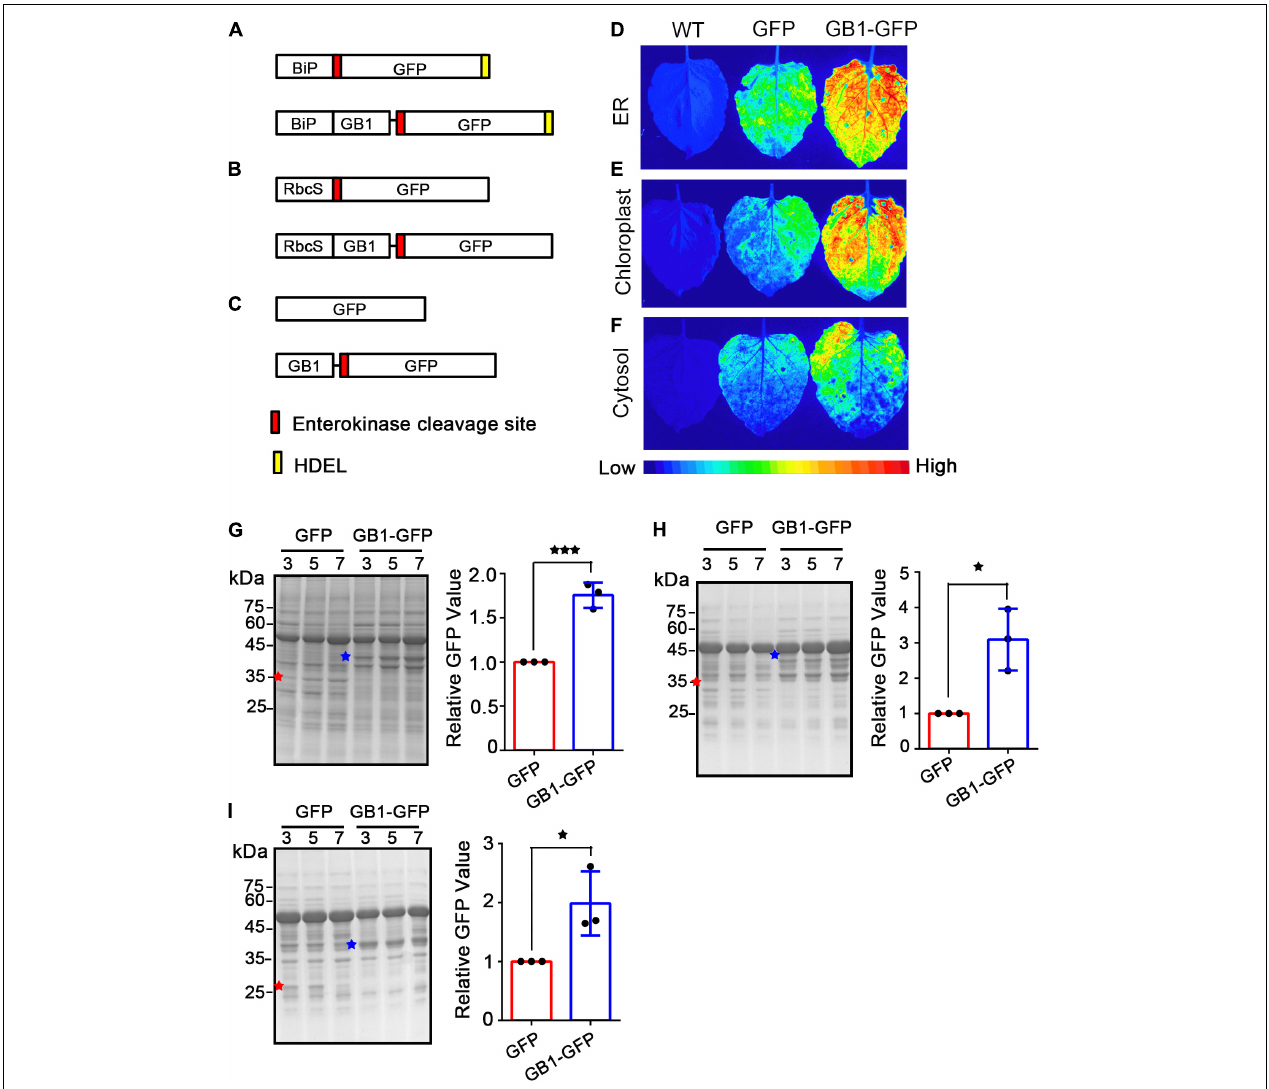
FIGURE 1 | GB1 dramatically increases the expression level of GFP in the leaves of Nicotiana benthamiana . (A–C) Schematic representation of constructs. BiP-EK-GFP-HDEL and BiP-GB1- EK-GFP-HDEL (A) , RbcS tp -EK-GFP-HDEL and RbcS tp -GB1-EK-GFP-HDEL (B) , and GFP-HDEL and GB1-EK-GFP-HDEL (C) . BiP, the leader sequence of BiP; RbcS tp , transit peptide of the rubisco complex small subunit. (D–F) Images of GFP fluorescence. GFP fluorescent signals of the constructs targeted to ER (D) , chloroplasts (E) , and cytosol (F) were measured from infiltrated leaves at 3 days post infiltration (dpi). (G–I) Coomassie brilliant blue (CBB)-stained GFP bands. Total protein extracts from infiltrated N . benthamiana leaves at 3, 5, and 7 dpi were separated by SDS-PAGE and stained with Coomassie brilliant blue. ER (G) , chloroplast (H) , and cytosol (I) -localized GFP (red asterisks) and GB1-GFP (blue asterisks). Band intensity was quantified and represented as a relative value to the GFP alone. Three independent experiments were carried out to quantify the signal intensity. Results in panels (G,I) are the mean ± SD ( n = 3). Asterisks indicate a significant difference (Student’s t -test; one asterisk and three asterisks indicate P < 0.05 and P < 0.001,